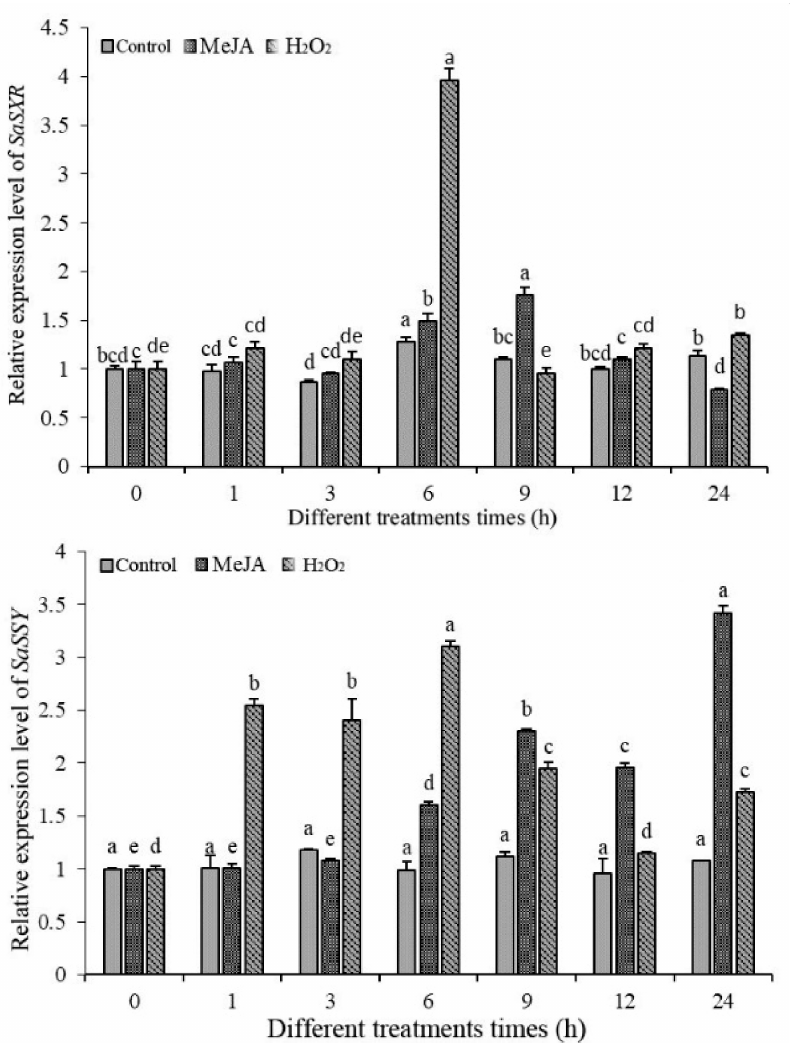
Figure 10. Expression analysis of SaDXR and SaSSy of 8-month-old S. album seedlings in response to two elicitors, 5 mM H 2 O 2 or 1 mM MeJA. Eight-month-old S. album seedlings treated with water were used as the control. Each value represents the means of three independent biological replicates ± SD. Different letters (a,b,c,d,e,f,g) above bars indicate significant differences across treatments (DMRT, p <